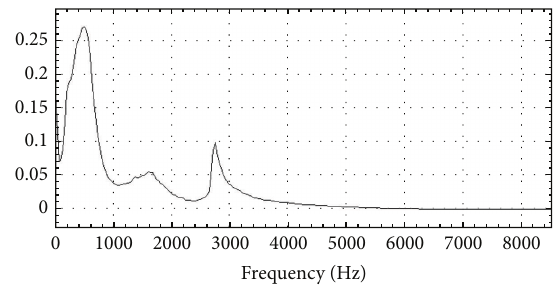
Figure 31: Hilbert marginal spectrum of effective microseism signals in working condition